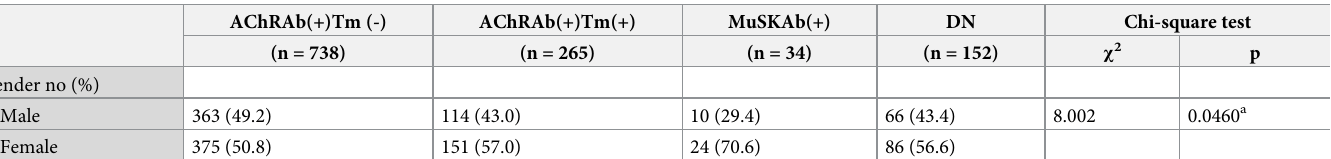
Table 3. Male to female ratio by categories.